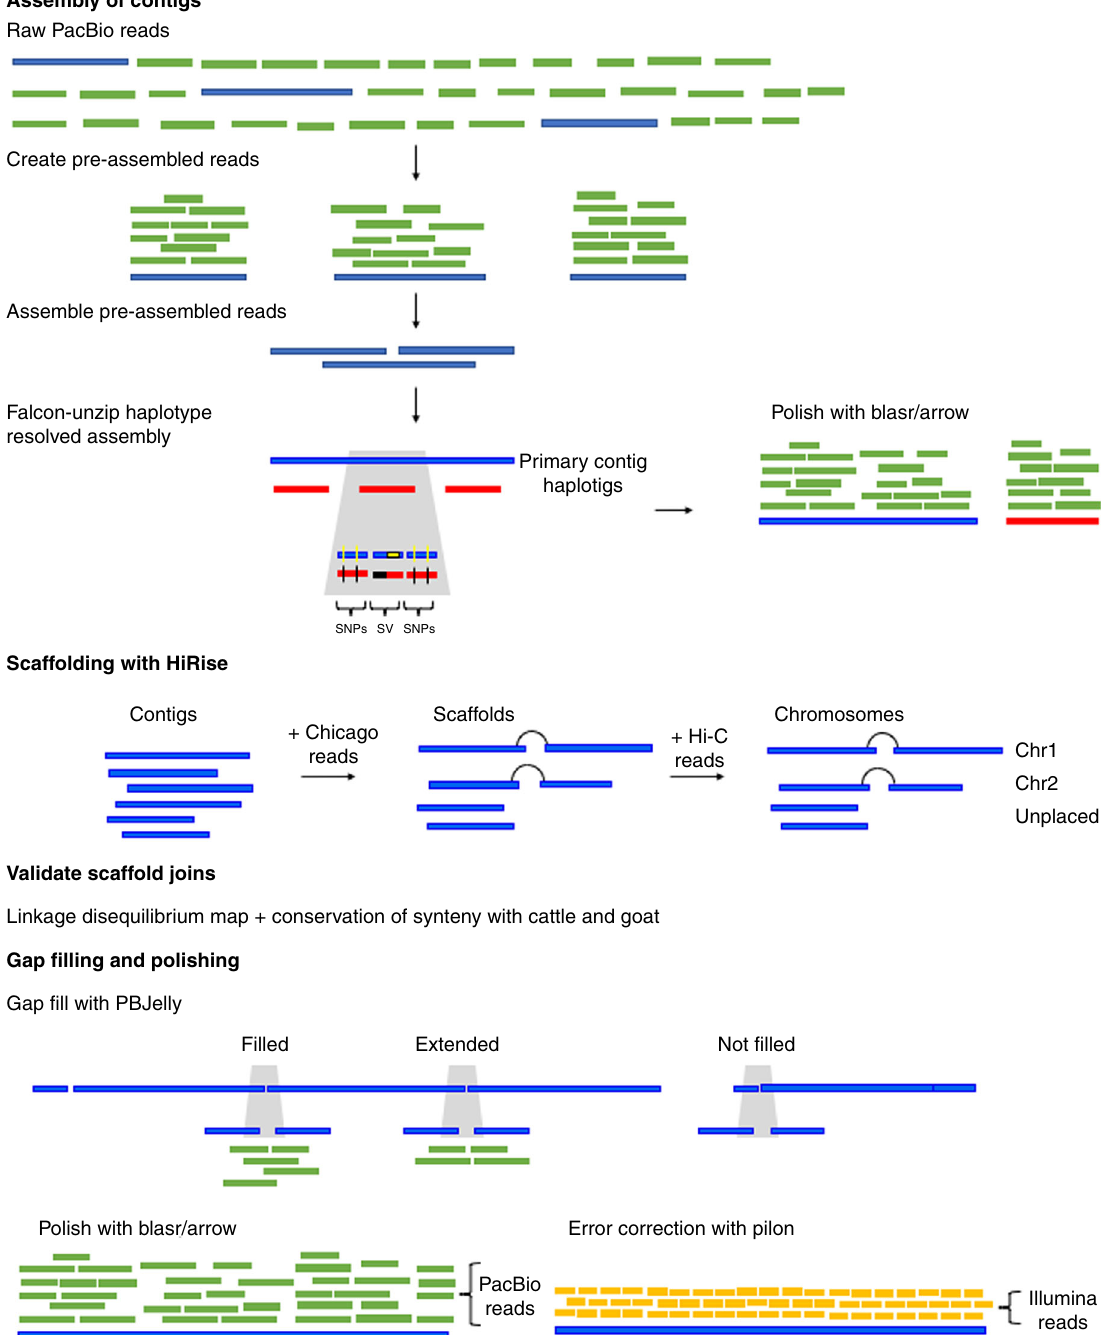
Fig. 1 An overview of assembly methods. Contig assembly was carried out with the diploid assembler FALCON-Unzip to produce primary contigs and haplotigs. It began with selection of longest “ seed ” reads and shorter reads were aligned to them to create pre-assemble reads using a consensus approach. The primary contigs were carried forward to the scaffolding step that began with Chicago reads for short range scaffolding (1 – 100 kb) with HiRise. Then long-range scaffolding (10 – 10,000 kb) was carried out with Hi-C reads to cluster scaffolds to the chromosome level. Each join of contigs to create a scaffold was checked against an LD map and for conservation of synteny with cattle and goat. Then long-reads were used to fi ll gaps and polish the sequence, followed by indel correction with short fi ve of the sub-metacentric buffalo autosomes, the scaffolds span the centromeres.